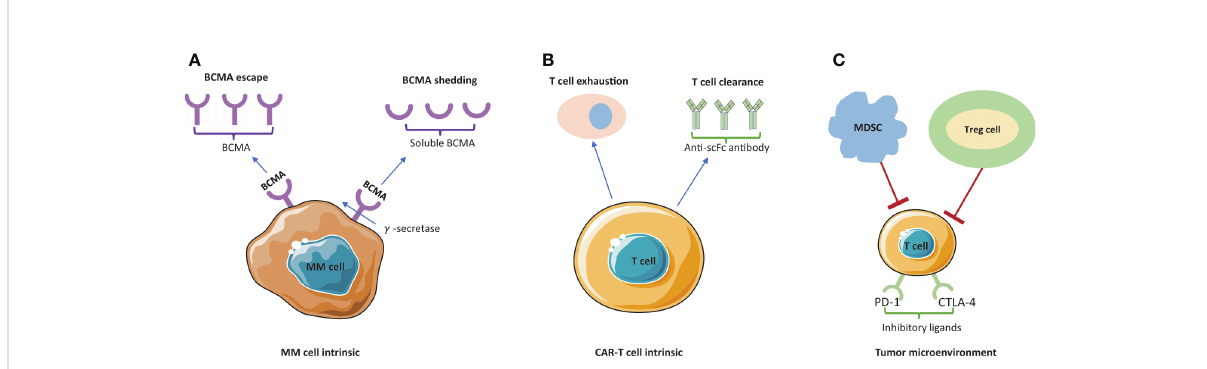
FIGURE 3 Mechanism of resistance/relapse to BCMA-targeted CAR-T cell therapy. (A) BCMA escape and BCMA shedding are blocking the antigen recognition by CAR-T cells. Membrane BCMA can be cleaved by g – secretase and released to the plasma as soluble BCMA (sBCMA). (B) Poor persistence of CAR-T cells is mainly caused by T cell exhaustion and T cell clearance. (C) The tumor immunosuppressive microenvironment is mainly led by inhibitory ligands (PD-1 and CTLA-4) and suppressive immune cells (MDSC and Treg cells). MM, multiple myeloma; MDCS, myeloid-derived suppressor cells; Treg cell, T regulatory